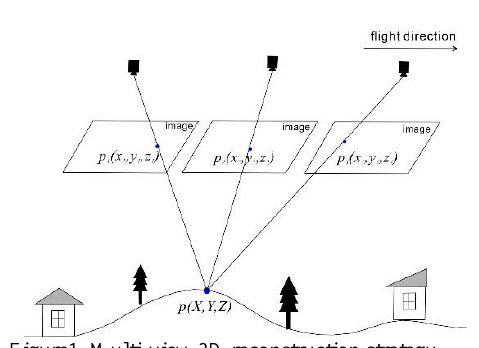
Figure1. Multi-view 3D reconstruction